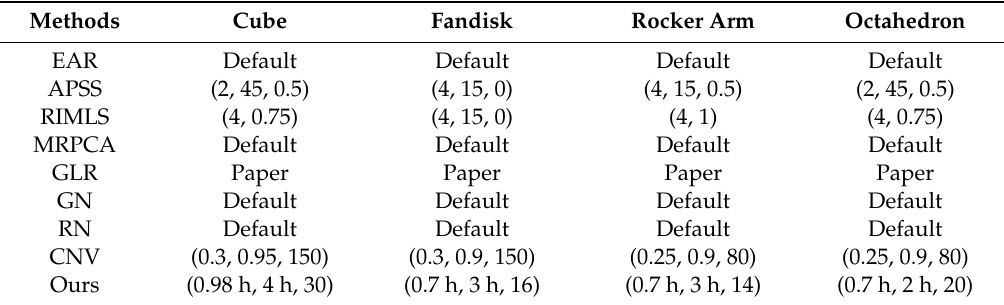
Table 1. Parameter settings of comparative methods for di ff erent